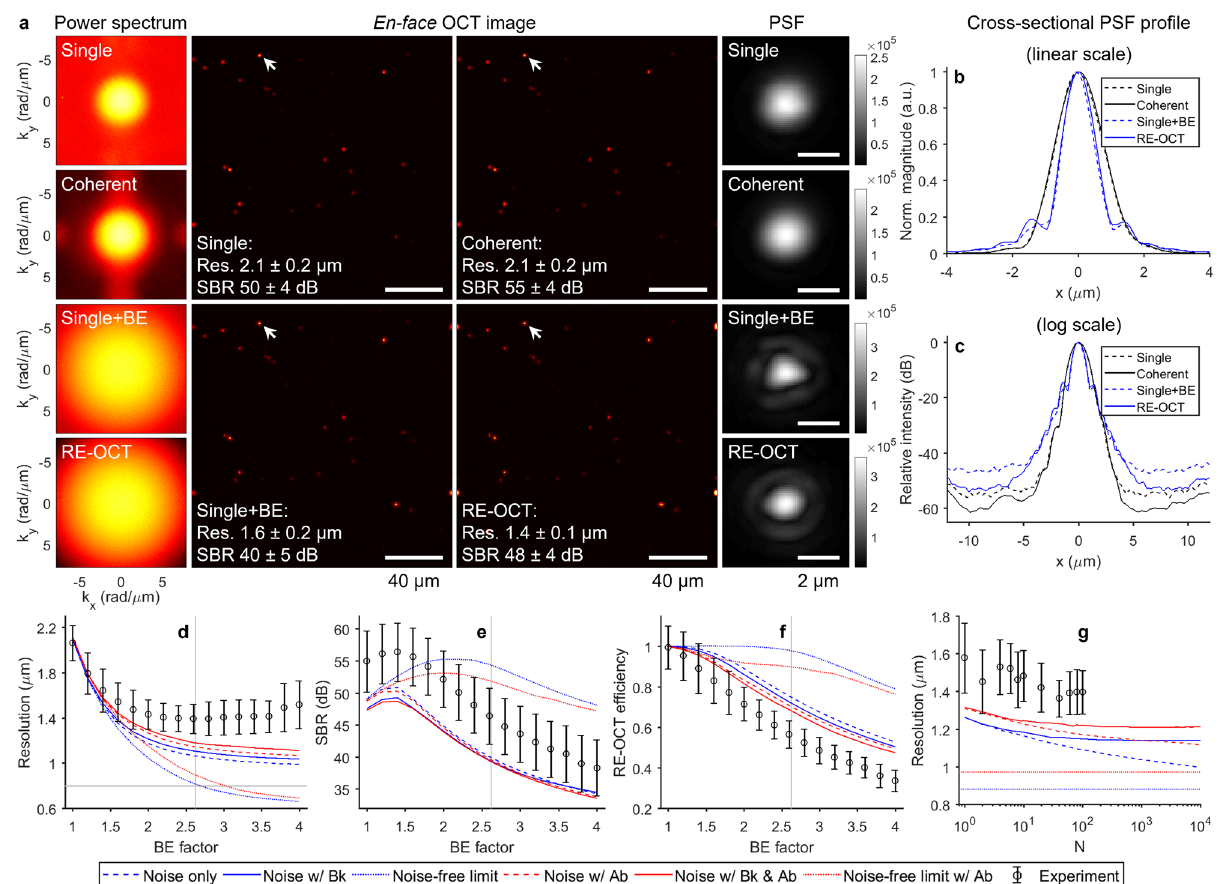
Figure 3. RE-OCT with 100 acquisitions and ×2.4 bandwidth expansion (BE) in silicone phantom. ( a ) Single-shot, coherent-average, BE single-shot, and RE-OCT power spectrums (log scale) and space-domain en face OCT image with zoomed PSF (linear scale). Resolution and SBR represent mean ± standard deviation of measurements from 11 particles. Scale bars, 40 µm (en face image) and 2 µm (zoomed PSF). ( b , c ) Cross- sectional profiles of zoomed PSF in ( a ) on peak-normalized linear and log scales. ( d – f ) Resolution, SBR, and RE-OCT efficiency as a function of BE factor from experiment and simulations for N = 100 of noise-free (dotted), noise only (dashed), and noise with background (solid) conditions, with (red) and without (blue) optical aberrations. Grey vertical lines indicate the Nyquist limit based on spatial sampling of 0.4 µm/pixel. ( g ) Resolution as a function of N from experiment and simulations for BE factor of 2.4. Resolution and SBR in ( a ) and data point and error bars for ‘Experiment’ in ( d – g ) represent mean ± standard deviation of